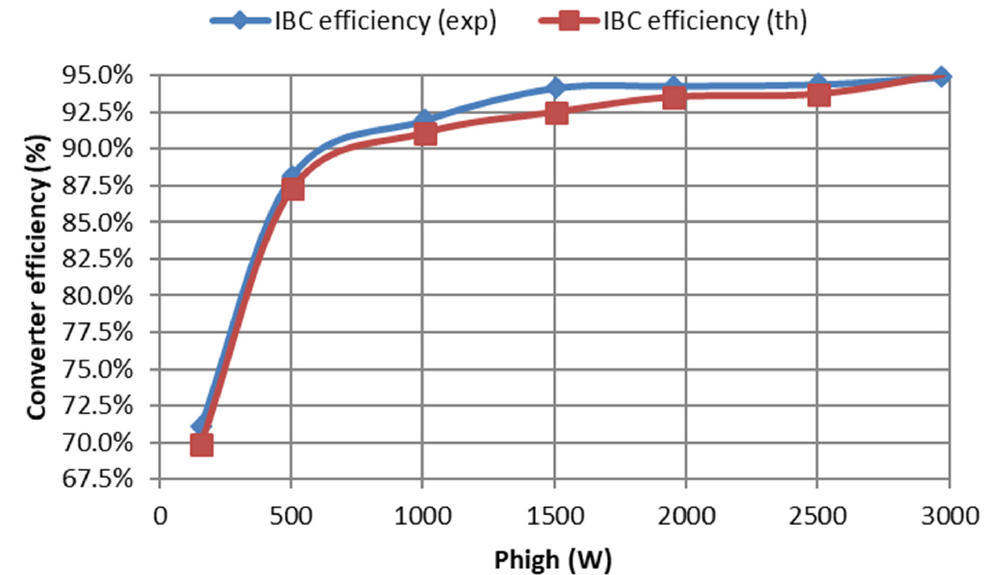
Figure 14. Prototype global efficiency at input voltage 700 V and output voltage 200 V; input power swept from 160 W to 2970 W.